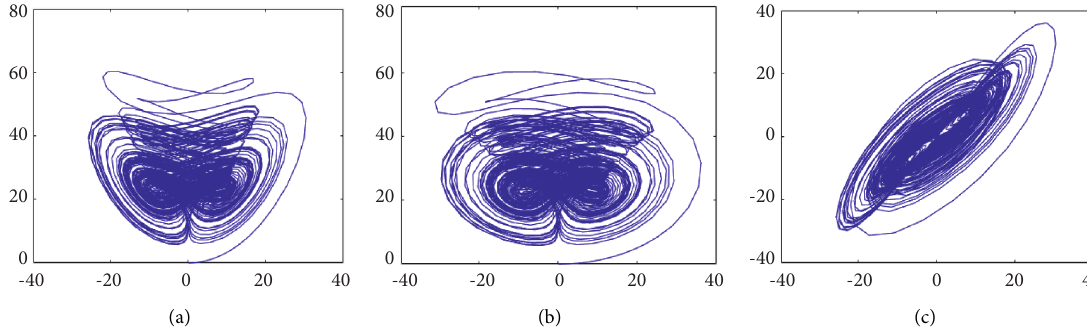
Figure 1: Numerically simulated phase portrait of Chen’s attractors: (a) x-z plane, (b) z-y plane, and (c) y-x